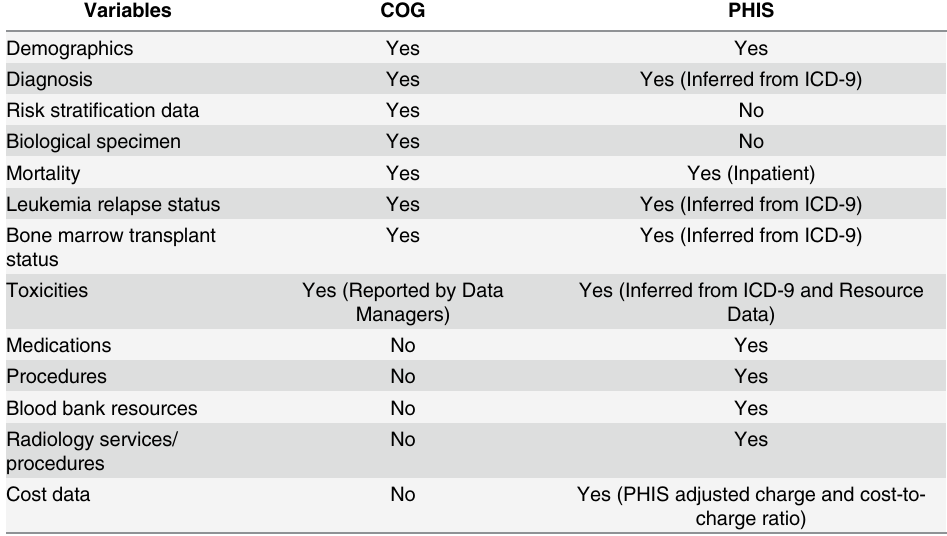
Table 1. Data elements available in COG and